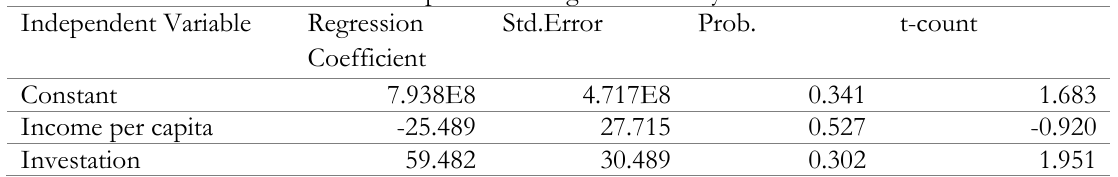
Multiple Linear Regression